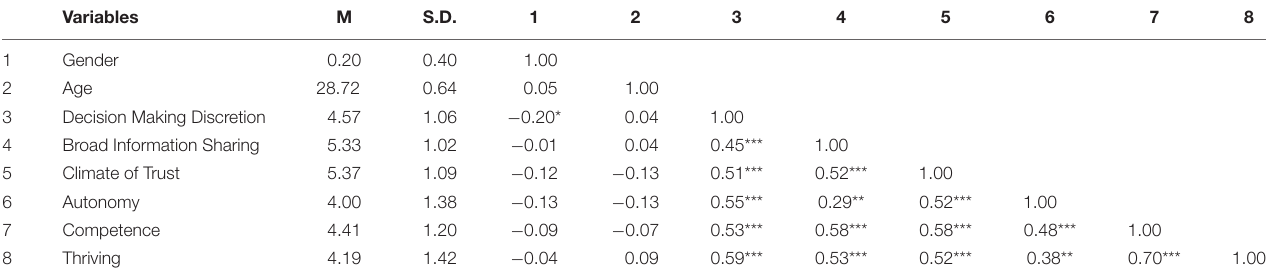
TABLE 3 | Means, standard deviation and inter-correlations for study 3.